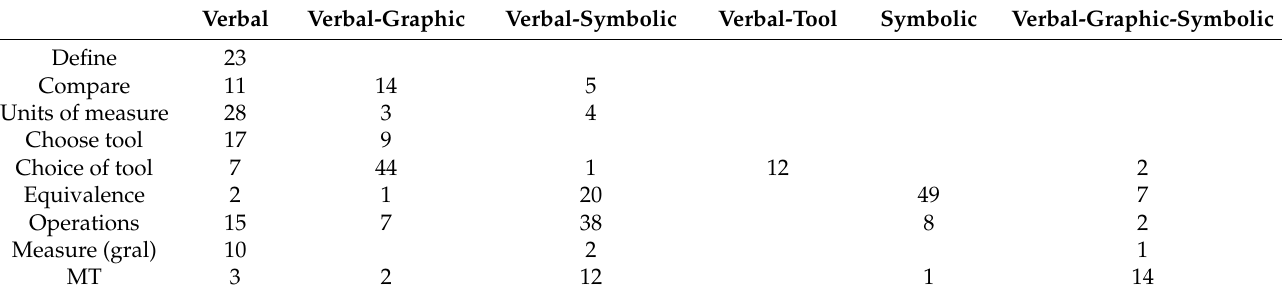
Table 6. Relationship between representation system and measurement